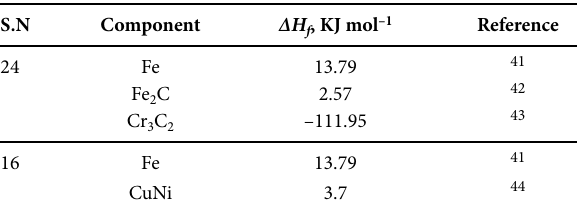
Table 10. Formation enthalpies of crystal observed in workpiec- es-16 and 24.